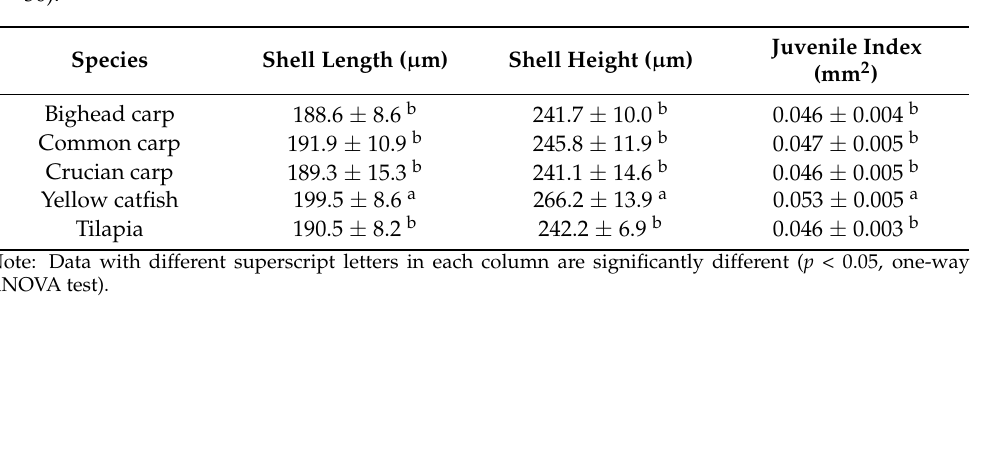
Figure 2. Developmental dynamics of Anodonta woodiana glochidia on the five host fish species. Bars represent the mean ± SD of the number of untransformed (white bars) and transformed (black bars) juveniles recovered per host fish on each day after infection. Table 3. Morphometry of freshly transformed juveniles from the five host species (mean ± SD; n =